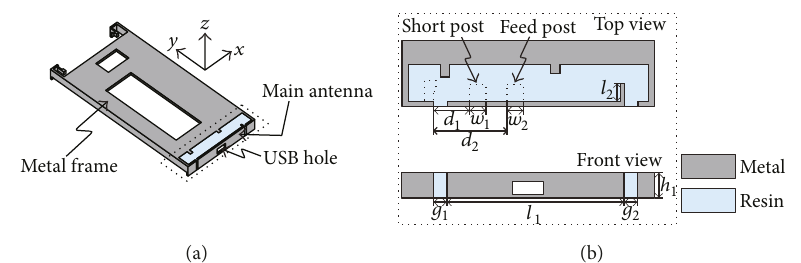
Figure 1: The geometry of a smartphone body and main antenna: (a) 3D view of the smartphone body and (b) expanded view of the main antenna.